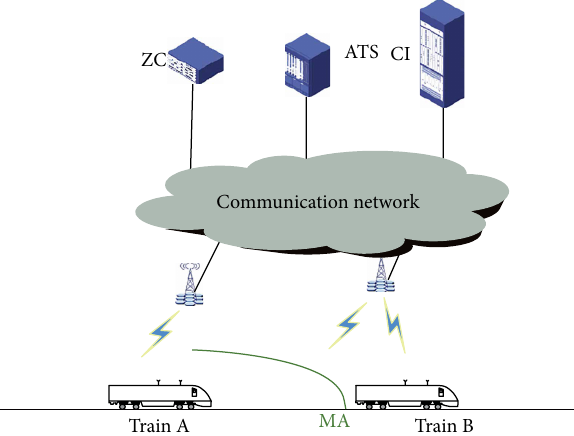
Figure 1: The structure of existing CBTC